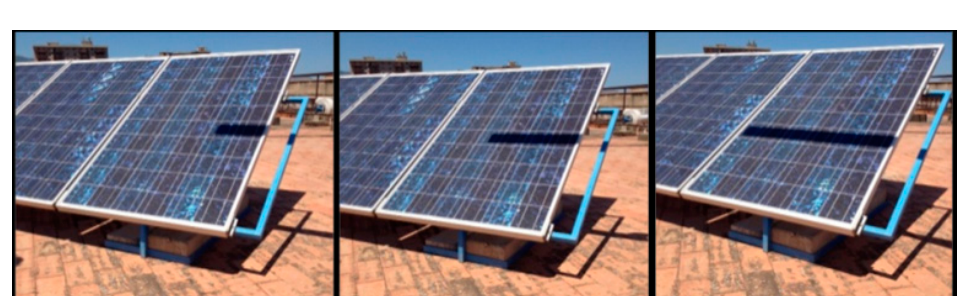
Figure 8. Shaded panel case 1, 2 and 3. In case 1 shadow can vary from 225 to 450 cm 2 ; which